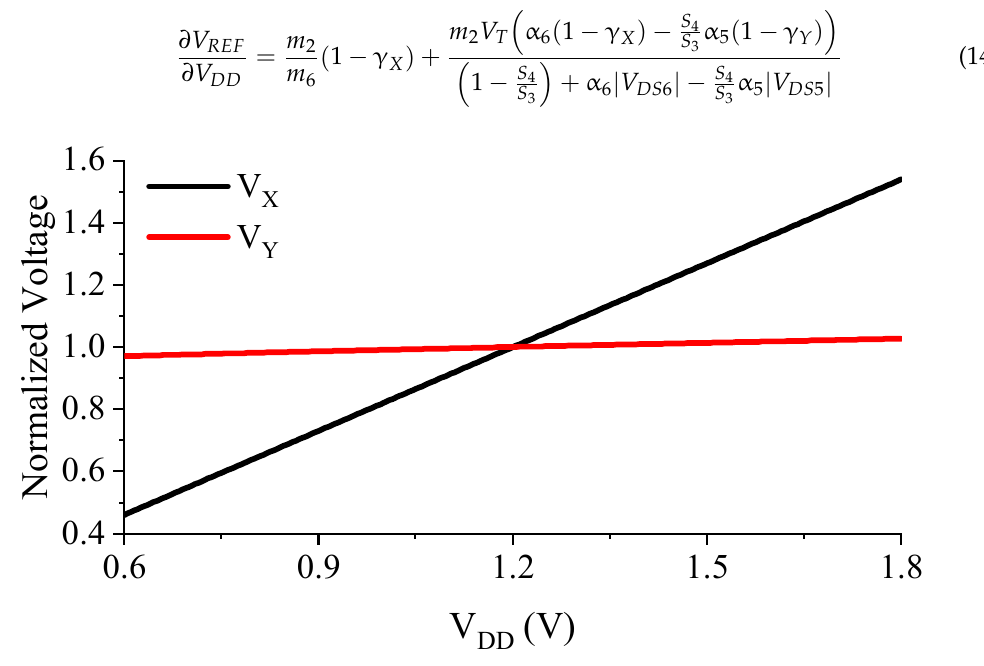
Figure 4. Linearity of the intermediate voltages V X and V Y . From the initial design point in Equation (16(cid:4667) , the final optimum value can be found after several iterations. As in Equation (7), a change in the ratio 𝑆 (cid:2872) /𝑆 (cid:2871) leads to a small change in 𝑉 (cid:3019)(cid:3006)(cid:3007) , which in turn affects 𝑉 (cid:3025) and, thus, also |𝑉 (cid:3005)(cid:3020)(cid:2874) | . Due to the DIBL effect of M6 and the fact that |𝑉 (cid:3008)(cid:3020)(cid:2873) | = |𝑉 (cid:3005)(cid:3020)(cid:2874) | , this then alters both biasing currents, requiring a re- adjustment of 𝑆 (cid:2872) /𝑆 (cid:2871) . As shown in Figure 5, there is a single optimum point at which to achieve the minimum LS, which is only dependent on the DIBL coefficient of M5. After starting with the initial value of 𝑆 (cid:2872) /𝑆 (cid:2871) , the next 𝑆 (cid:2872) /𝑆 (cid:2871) can be decided depending on the sign of 𝜕𝑉 (cid:3019)(cid:3006)(cid:3007) /𝜕𝑉 (cid:3005)(cid:3005) . If the sign is negative, it is over-compensated, and 𝑆 (cid:2872) /𝑆 (cid:2871) needs to be smaller, and vice versa.